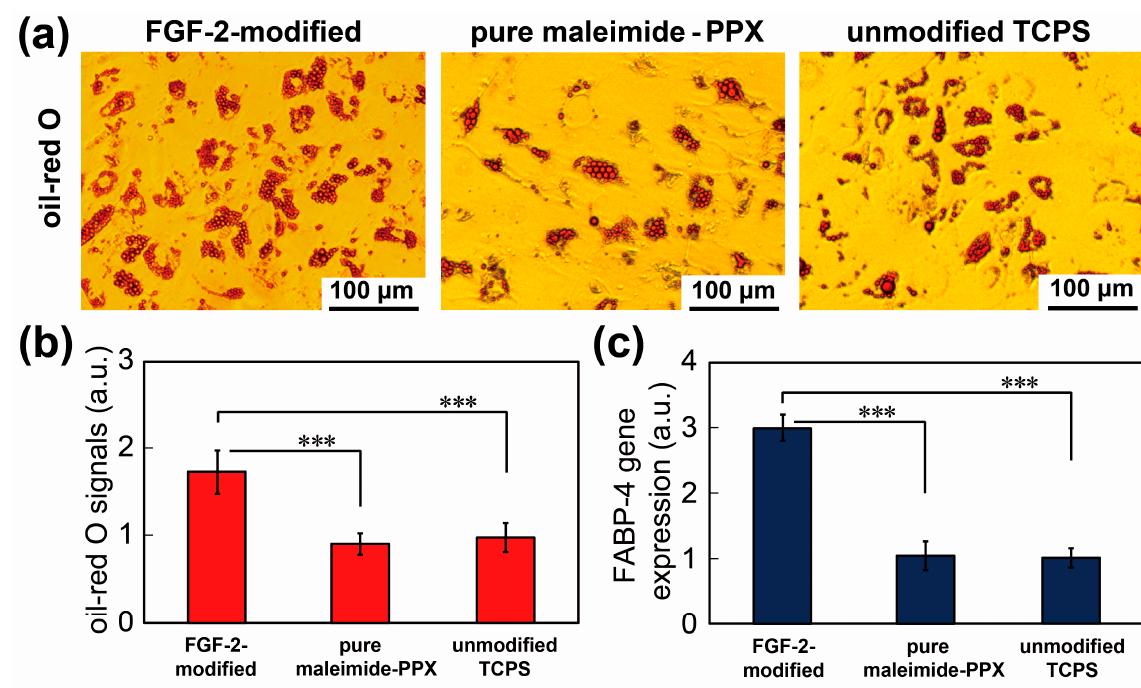
Figure 5. The adipogenic activities of the hADSCs were examined on the studied surfaces. ( a ) Recorded oil-red O staining images of differentiated cells on these surfaces at day 10. Statistical analyses of the ( b ) oil red O signal intensities obtained by spectrophotometry and the ( c ) FABP-4 marker gene expression obtained by quantitative PCR was performed and compared for these sample surfaces. The data bars represent the mean value (n = 3) and the standard deviation ( ± SD) based on three independent experiments. The significance level *** stands for *** p < 0.001, and is shown by the results of the unpaired t -test.